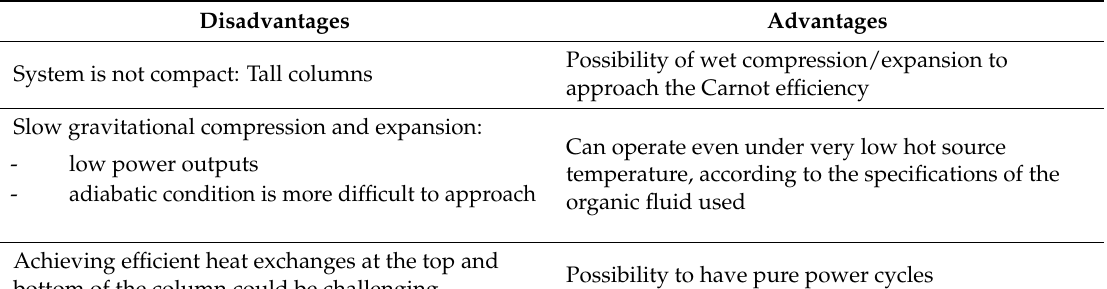
Table 1. Disadvantages and advantages of thermogravitational cycle